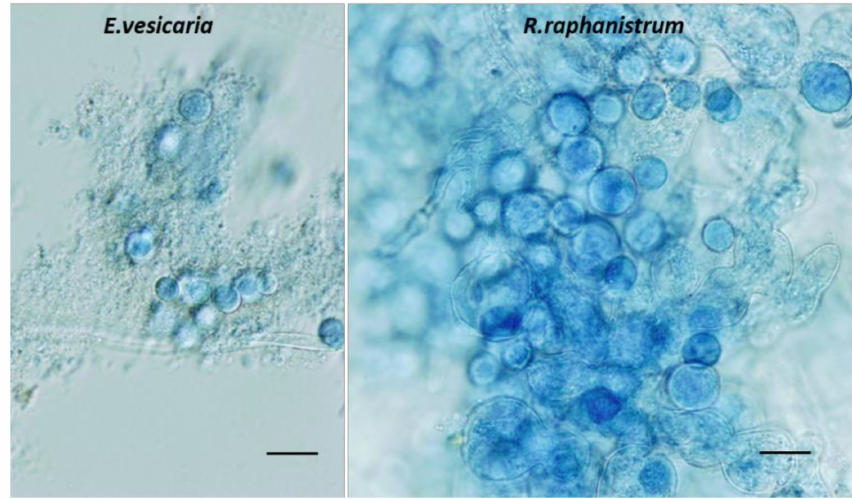
Figure 2. Zoospores encystment of Phytophthora cinnamomi in a non-sterile soil extract in presence of E. vesicaria and R. raphanistrum AREs. Bar 10 µ m.